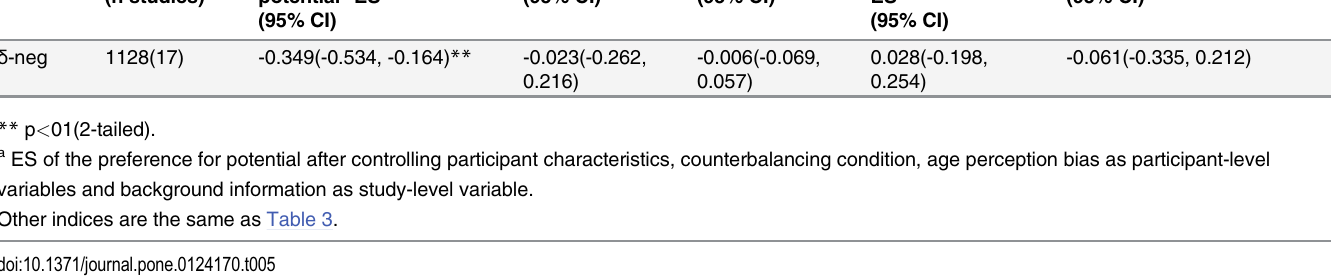
Table 5. The effect of background information as a study-level variable on preference for potential. Outcome n participants (n